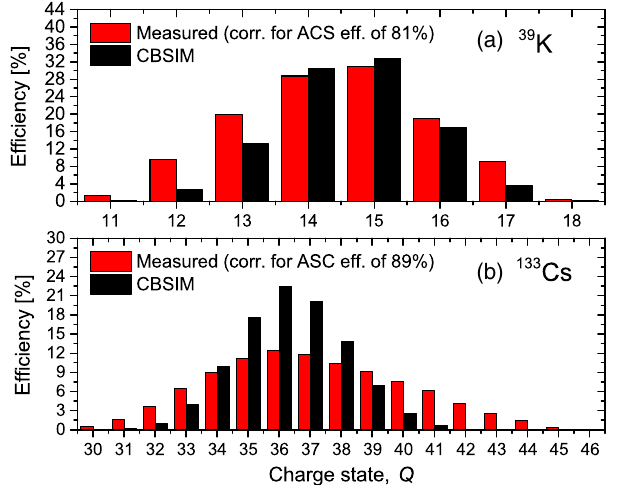
FIG. 9. Measured charge-state distributions compared with CBSIM simulations: (a) 39 K and (b) 133 Cs. Unlike the 133 Cs distribution, the 39 K distribution is slightly broader, but in satisfactory agreement with the simulated distribution (see text for